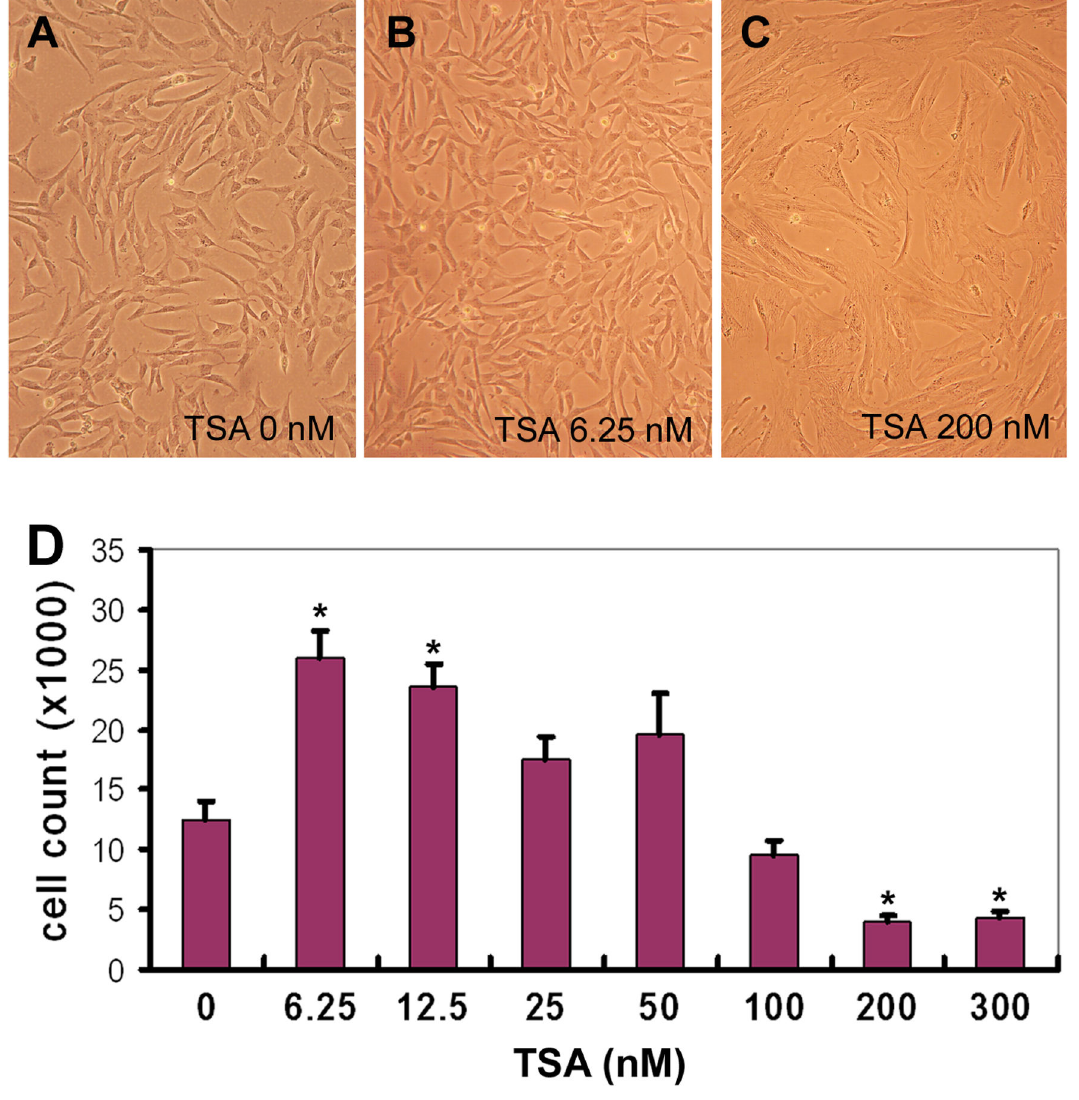
Figure 2. TSA treatment of hMSCs. Human MSCs were grown in the presence of different concentrations of TSA (0 ~ 300 nM) for 3 days and photographed under microscope. Reprehensive images were shown (A-C). Then the cells were detached and counted. Triplet wells were used for each experiment (D, n=4, * P